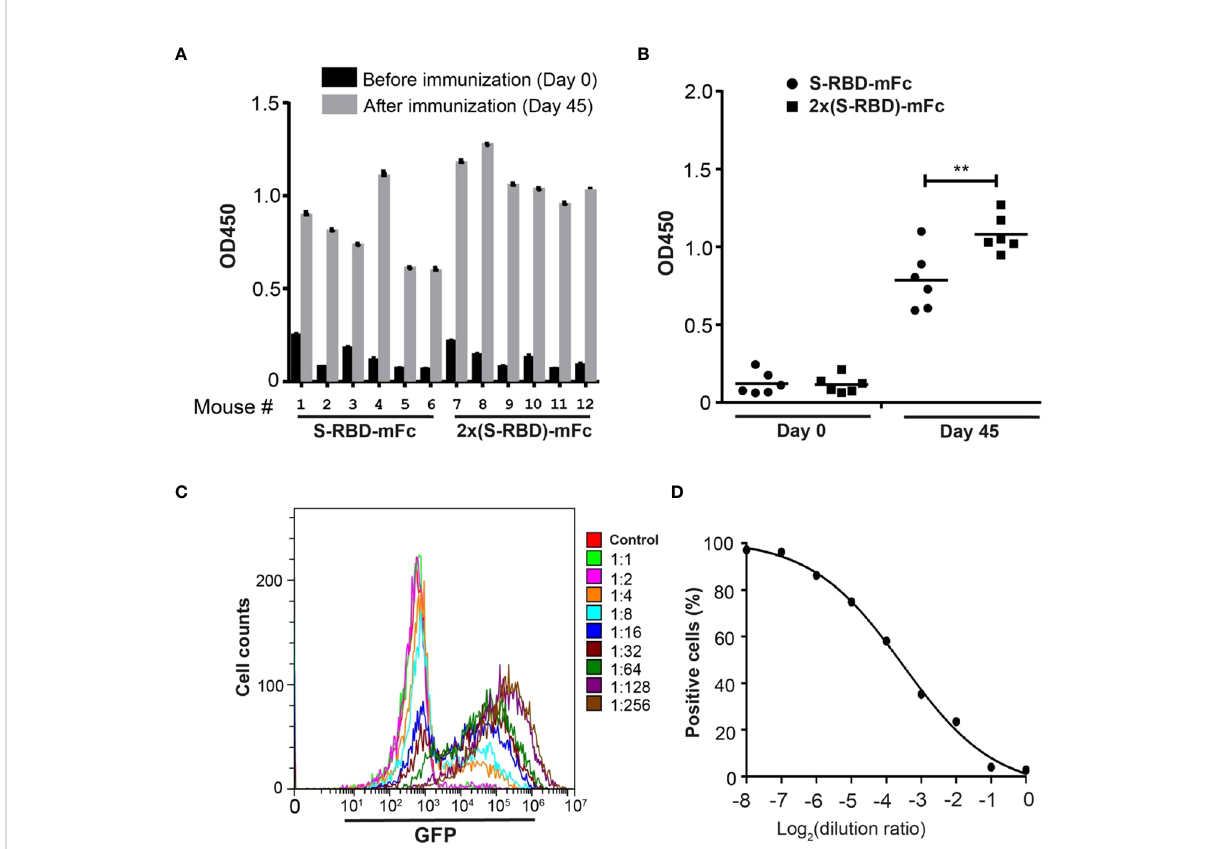
FIGURE 5 2xS RBD -mFc as a vaccine to generate neutralization antibodies. (A) ELISA assays of the anti-RBD antibody activity from antisera before and at day 35 after immunization. (B) The antibody activity in antisera immunized with S RBD -mFc is signi fi cantly less than that in the antisera immunized with 2xS RBD -mFc (**, P ≤ 0.01, n=6). (C) Flow cytometry diagrams show the GFP expression in HEK293T-hACE2 cells and HEK293T-hACE2 cells at 48h after infection with SARS-CoV-2 spike pseudo viruses premixed with mouse #8 antisera at a 2-fold dilution series. (D)